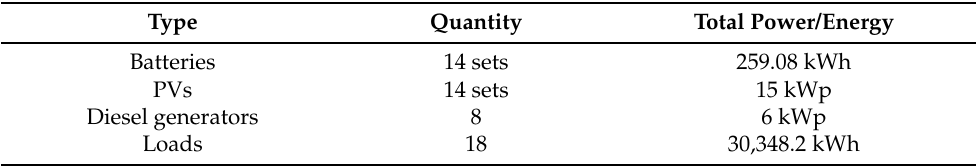
Figure 3. LMRA microgrid load profiles: High Consumption Profile (blue), Medium Consumption Profile (red), and Low Consumption Profile (green). Table 1. Existing